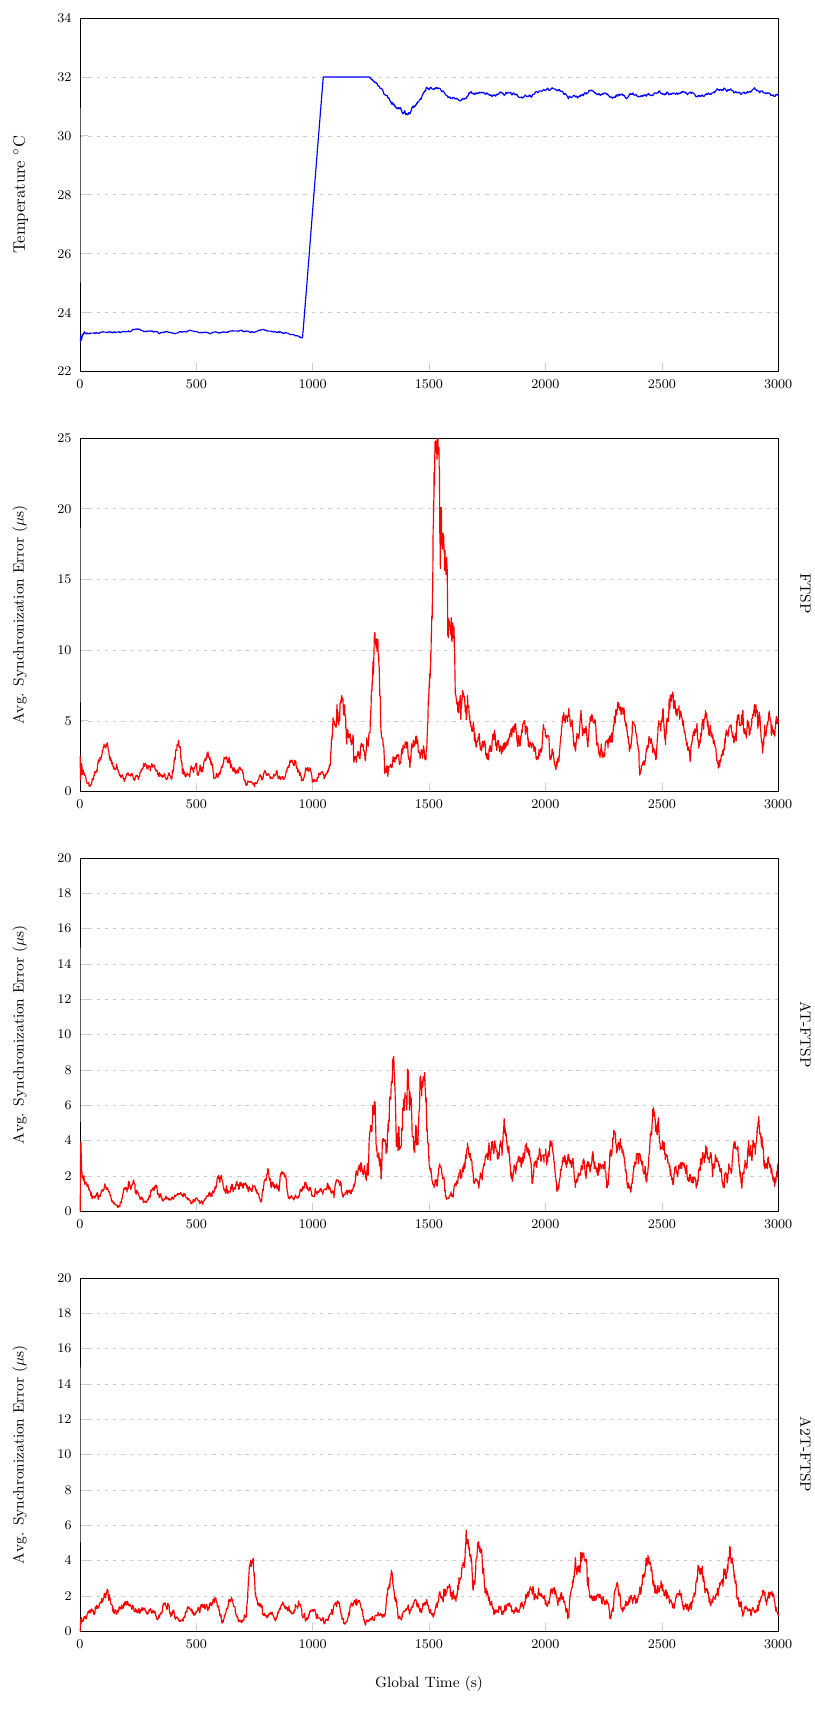
Figure 5. Intermediate temperature